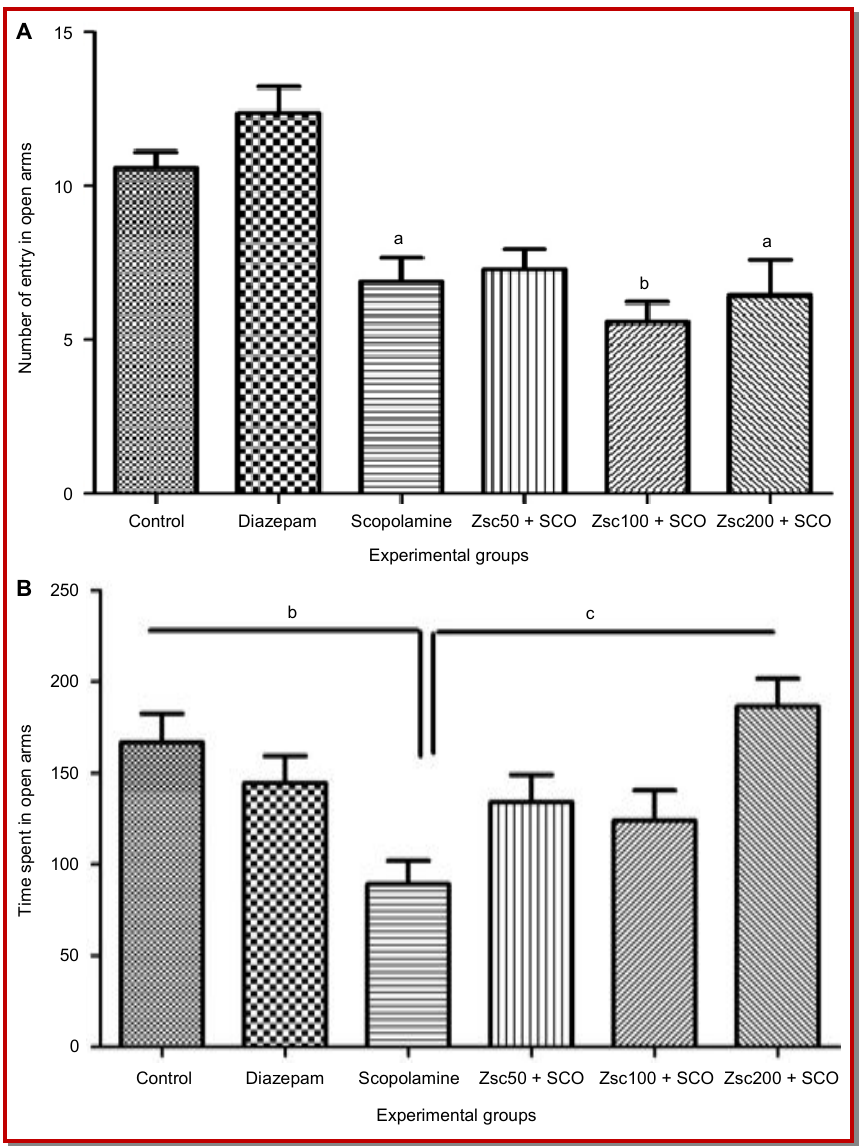
Figure 1: Effects of Z. spina-christi extract (50, 100 and 200 mg/kg) on: A) the number of entries in the open arms, B) the amount of time spent in the open arms; C) the number of entries in the closed arms; D) the amount of time spent in the closed arms. Data are presented as mean values (M ±